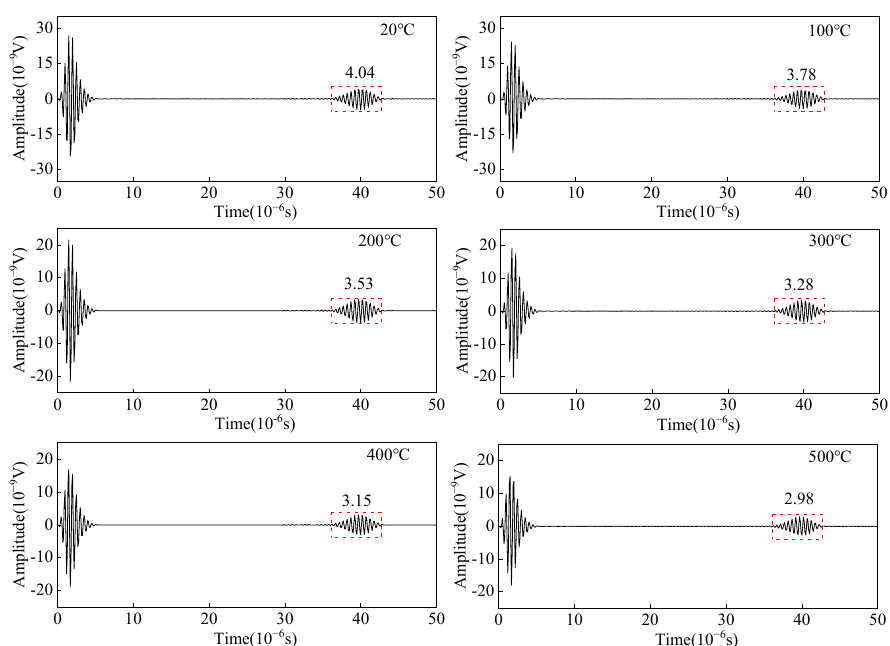
Figure 11. Open-circuit inducted voltage from angled SV wave EMAT in carbon steel specimens at different temperatures.